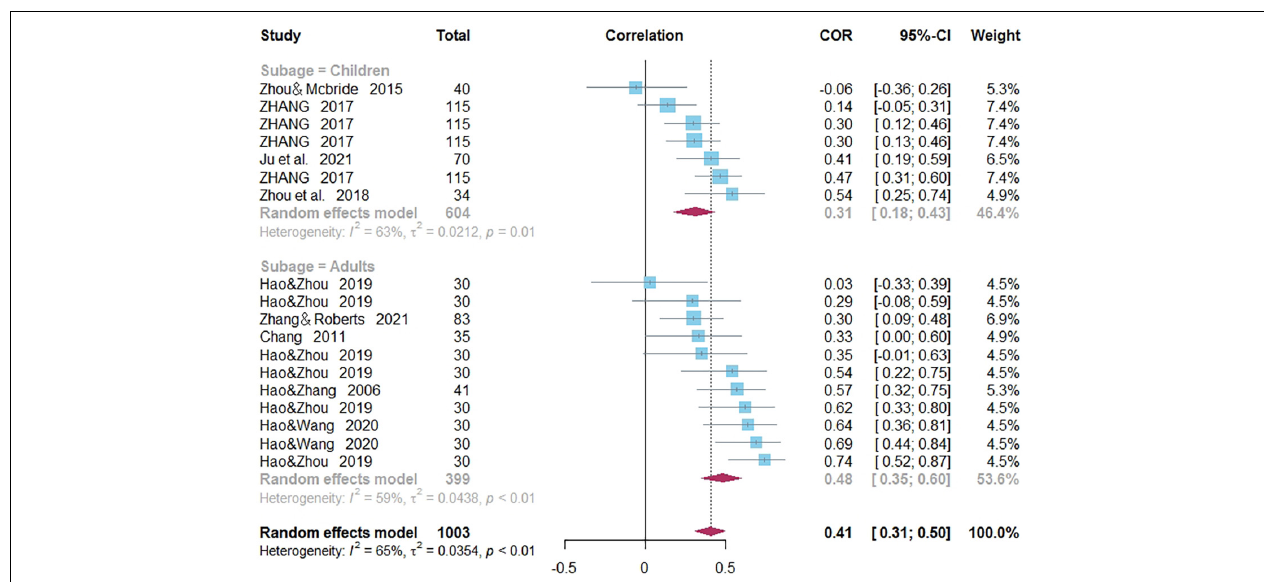
FIGURE 10 | Forest plot for age subgroup analysis between phonological awareness and reading.